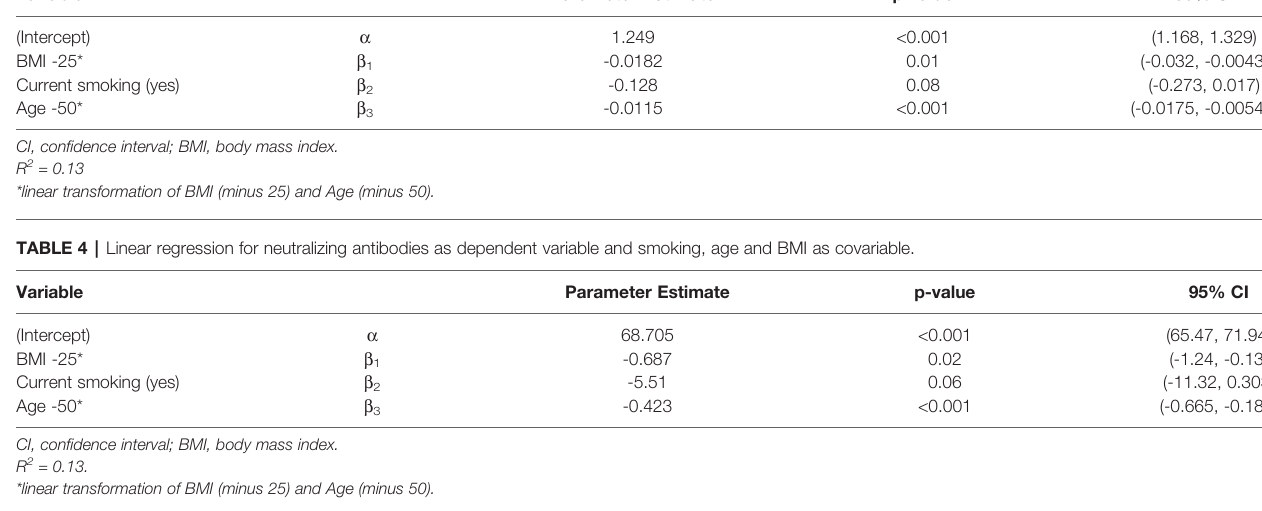
TABLE 3 | Linear regression for Anti-SARS-CoV-2 antibody ratio as dependent variable and smoking, age and BMI as covariable. Variable